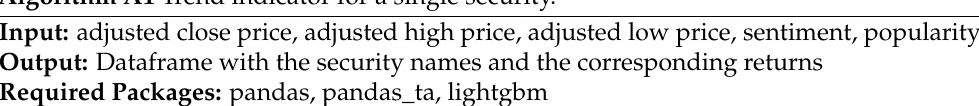
Algorithm A1 Trend indicator for a single